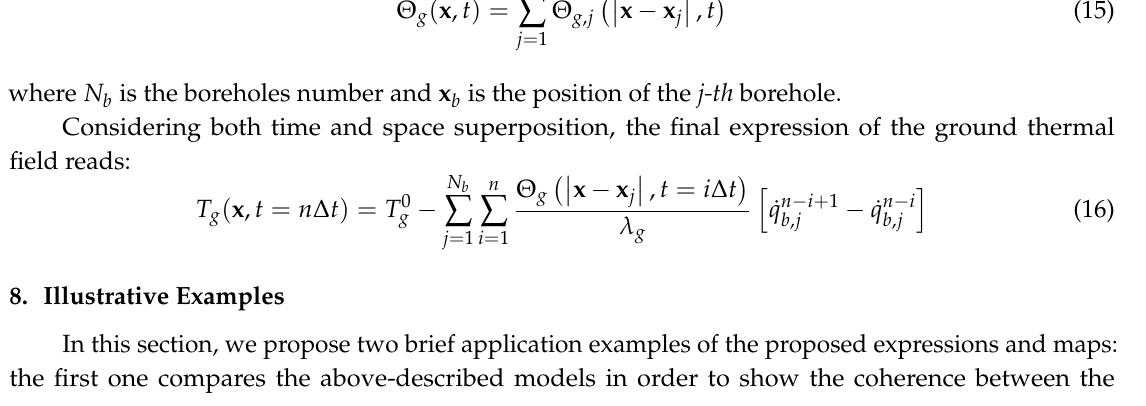
, ˙ q ∗ , ˙ q ∗ , ˙ q ∗ . ( a ) Actual thermal pulses; ( b ) effective thermal 2 3 1 4